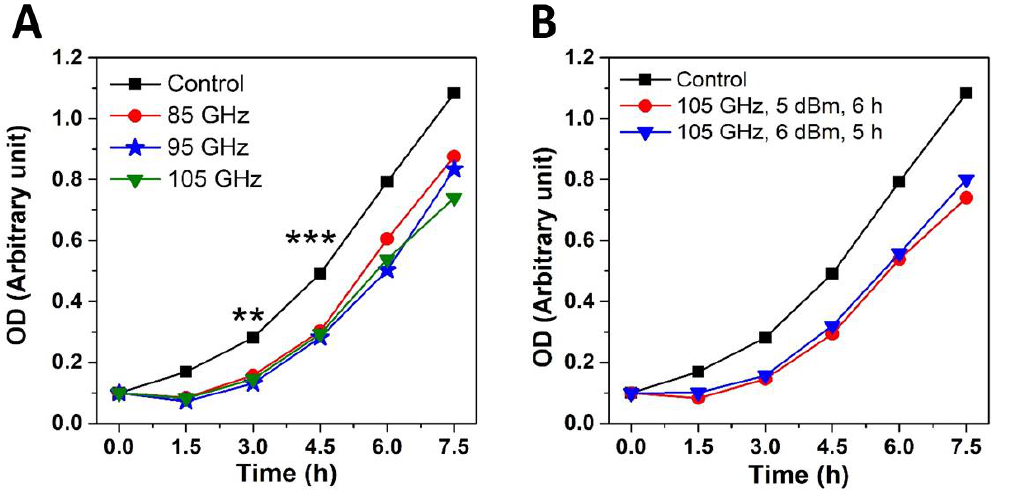
Figure 1. ( A ) Growth profiles of BY4741 Saccharomyces cerevisiae (50 cells/µL) cells measured in OD units after irradiation for 6 h at 5 dBm. Plots indicate mean values of growth rate of six separate yeast colonies ( n = 6) for each discrete frequency regime. Single Factor Analysis of variance (ANOVA) analysis (** indicates p value < 0.01 and *** indicates p value less than < 0.001) ( B ) Growth profiles of BY4741 Saccharomyces cerevisiae (50 cells/µL) cells subsequent to irradiations of different time durations and power densities for a constant frequency (and constant energy) at 105 GHz.